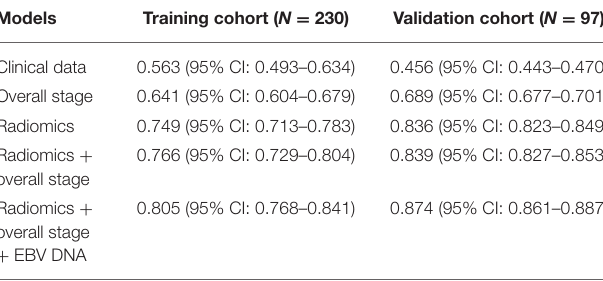
TABLE 3 | C-index of the five